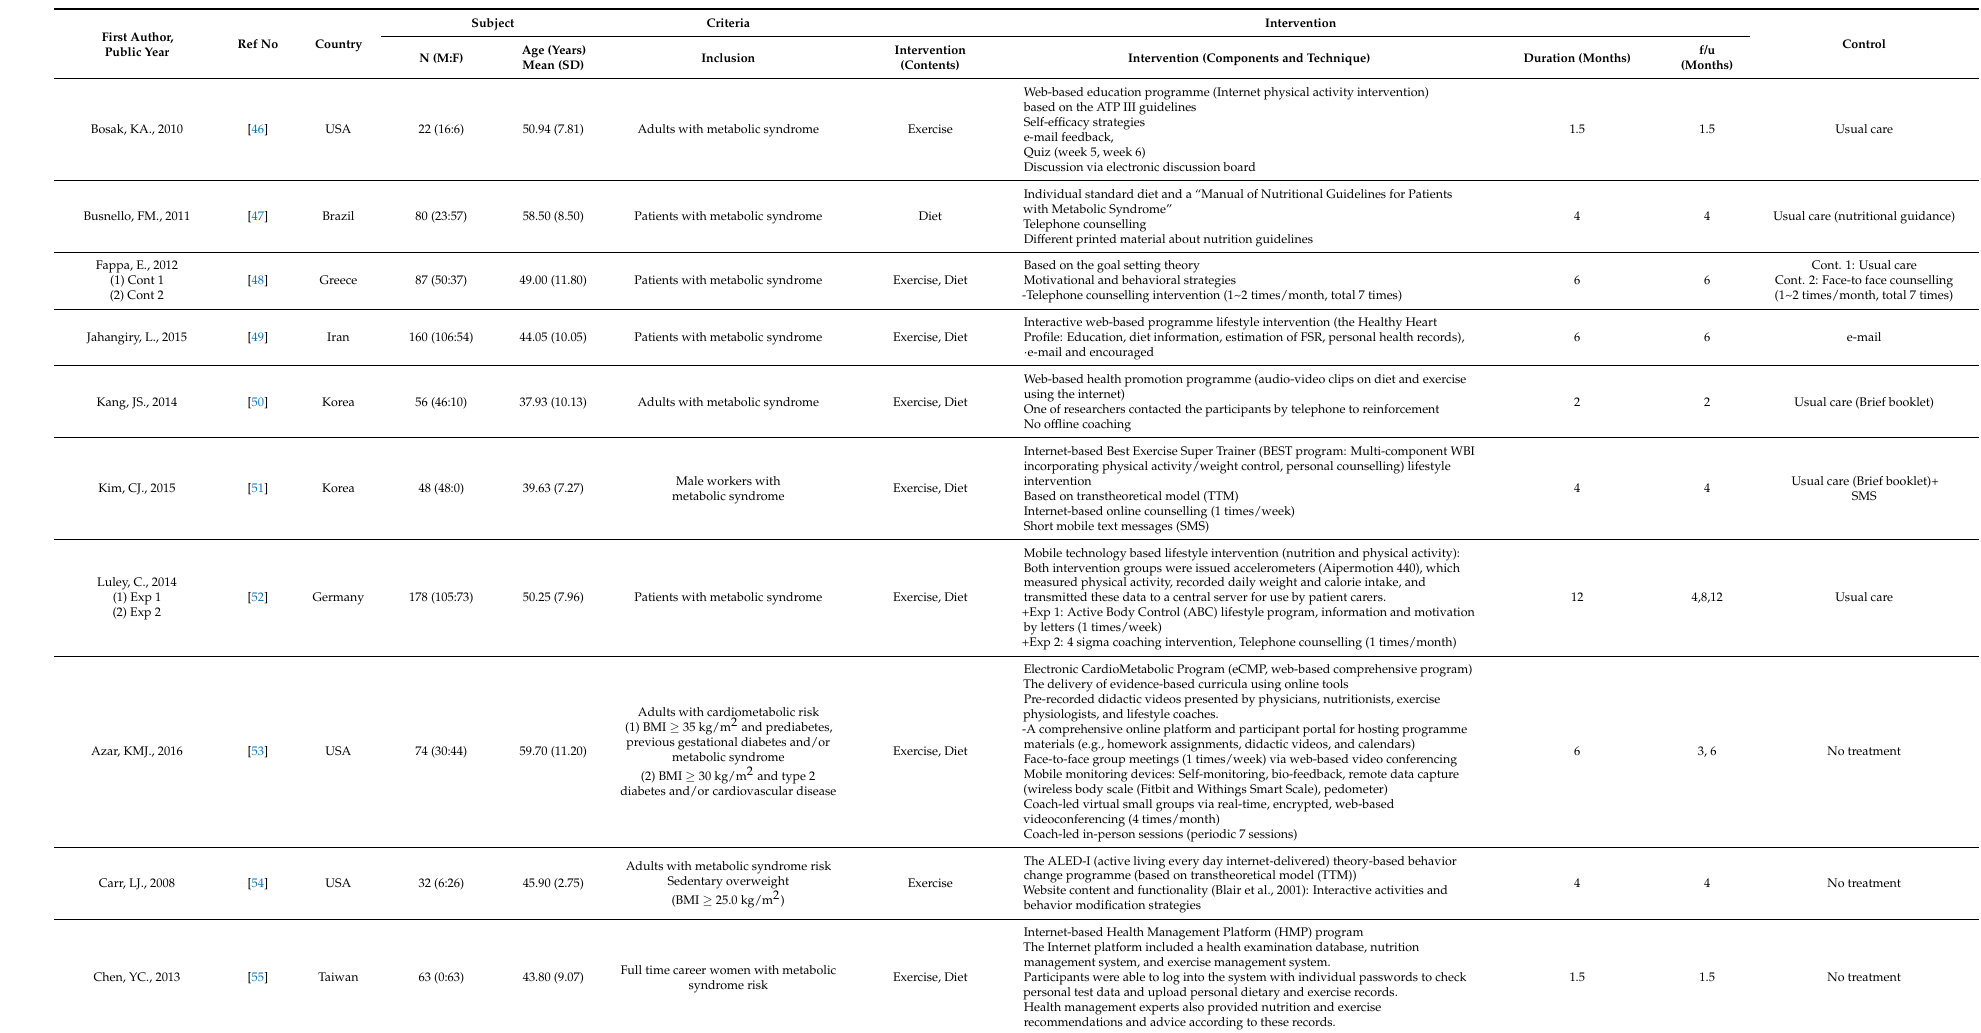
Table 1. Main characteristics of included